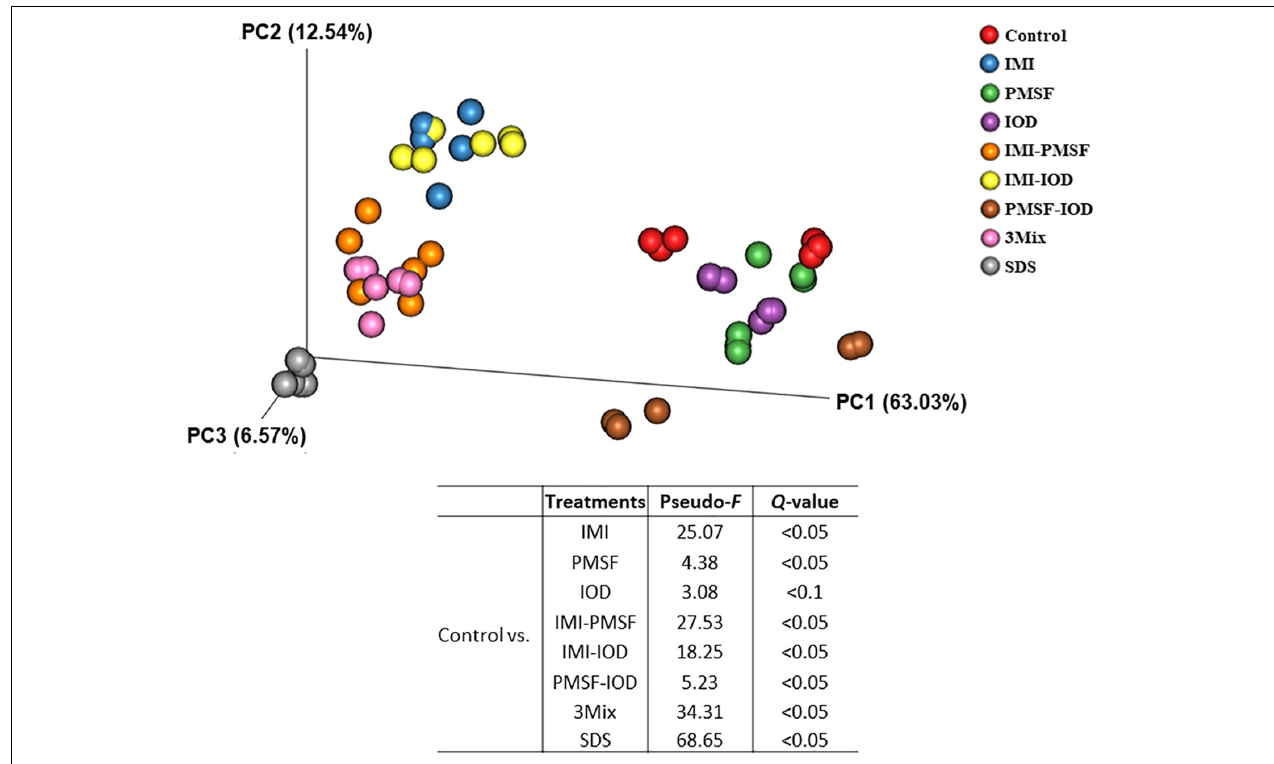
FIGURE 1 | Principal coordinates analysis based on the weighted UniFrac distance matrices of the prokaryotic microbiota in the in vitro cultures. PERMANOVA results of the pairwise comparison of the overall microbiota structures between control and each of inhibitor treatment was